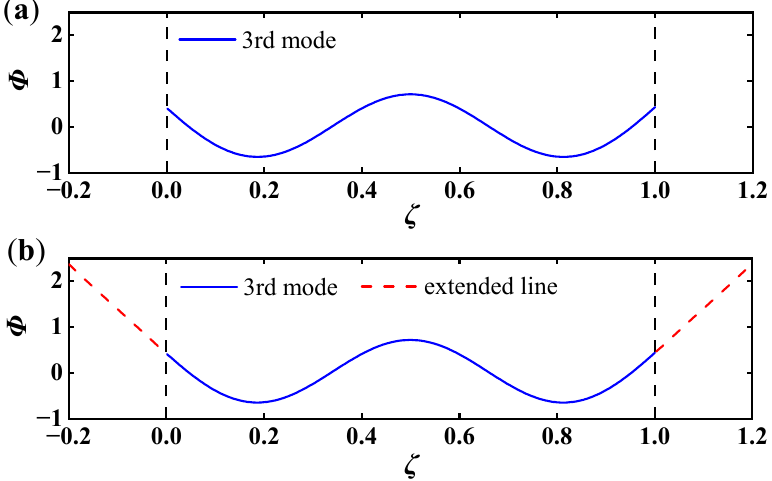
Figure 2. Third mode shape of the FF beam: ( a ) no boundary extension; ( b ) boundary extension.